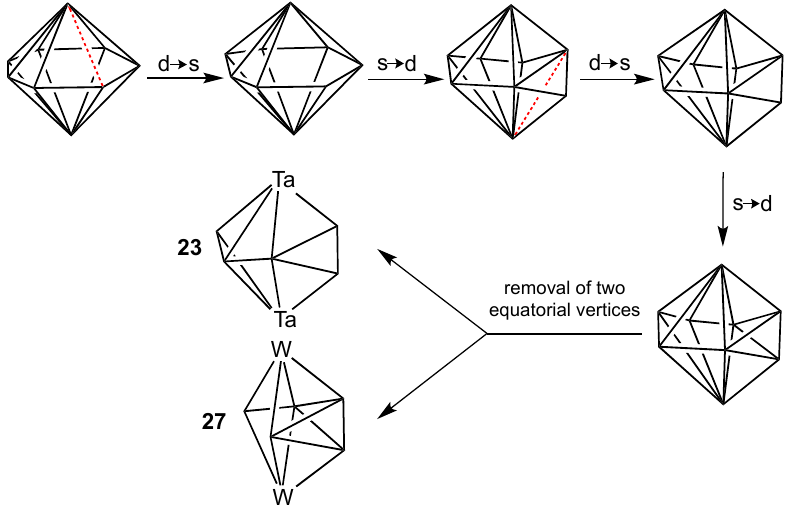
Figure 8. Generation of the oblatoarachno structure of clusters 23 and 27 from an oblatocloso structure.